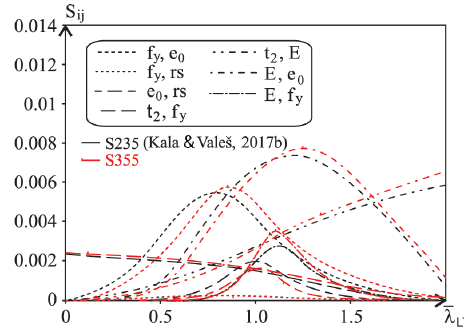
Figure 6. Second order Sobol’ sensitivity indices 67×47 mm